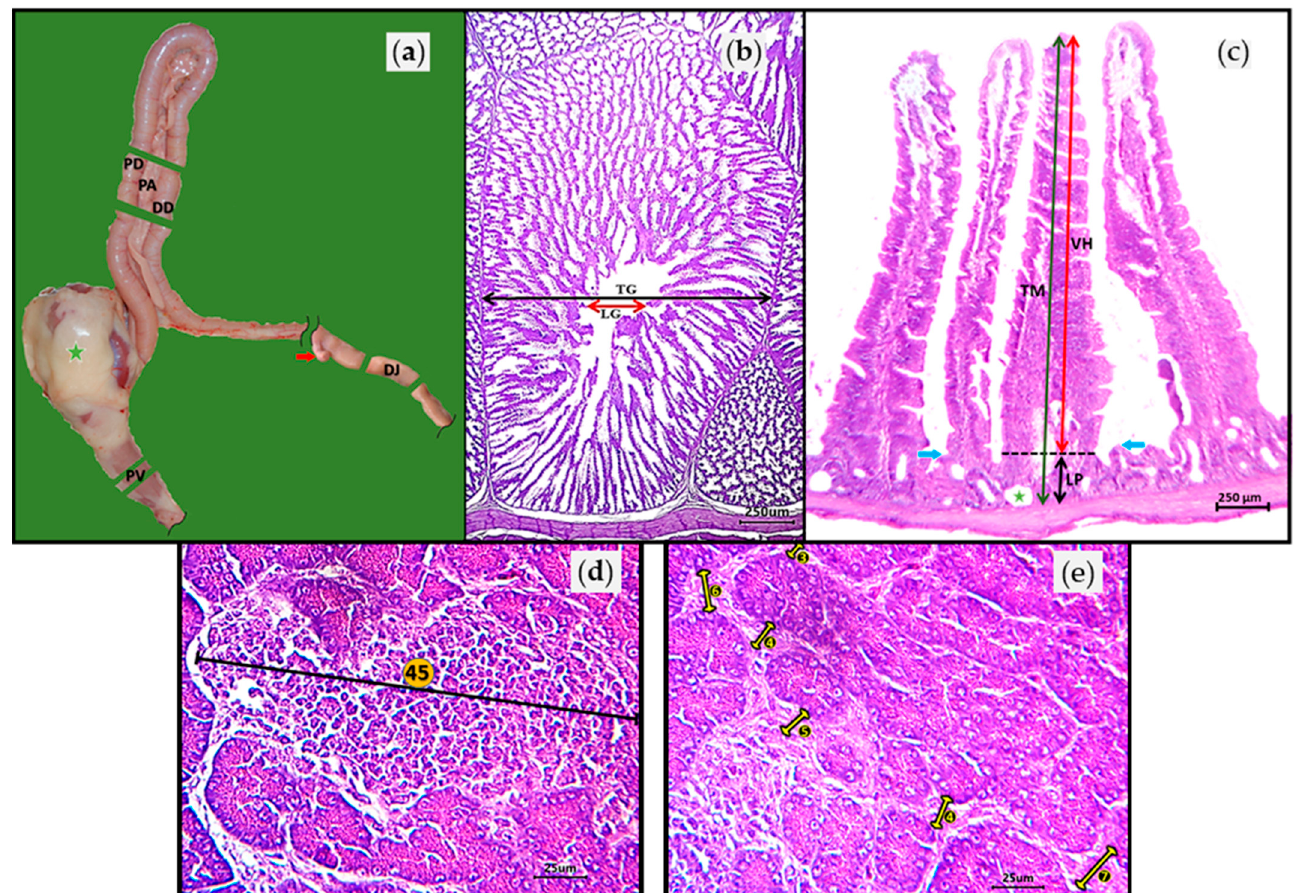
Figure 2. ( a ) Sites where histopathological samples were taken from each chicken from the middle parts of the proventriculus (PV), pancreas (PA), proximal duodenal branch (PD), and distal duodenal branch (DD), as well as 3 cm caudally to Meckel’s diverticulum (red arrow) in the distal jejunum (DJ). Green star = ventricle (gizzard); ( b ) PV consisted of measuring the transverse diameter of the total (TG and black arrow) and luminal (LG and red arrow) diameter of the proventricular gland; ( c ) Intestinal evaluation involved measuring the total thickness (TM, green arrow) and lamina propria (LP, black arrow) of the mucosa, as well as the villous height (VH, red arrow). The segmented line indicates the boundary between LP and VH. The blue arrows indicate the upper pole of the enteric glands that comprise the lintel of the LP. The green star indicates an enteric gland cyst; ( d ) Pancreas histopathologic analysis showing the lymphocyte cluster. The largest cross-diameter (black line) of the lymphocyte clusters was used to quantify the number of lymphocyte cell layers (number in orange circle); ( e ) Pancreas parenchyma. The acinar fibrosis/atrophy score was based on the number of fibroblast layers (number in black circle) embedded in bands separating the pancreas acini.